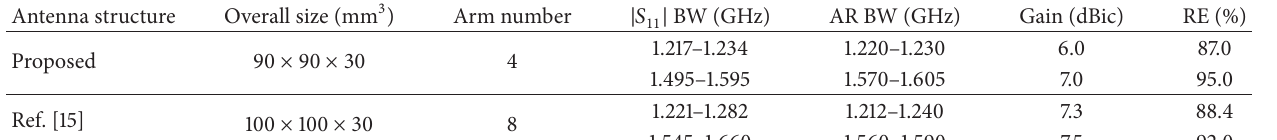
Table 1: Performance comparison of dual-band multiarm curl antennas.